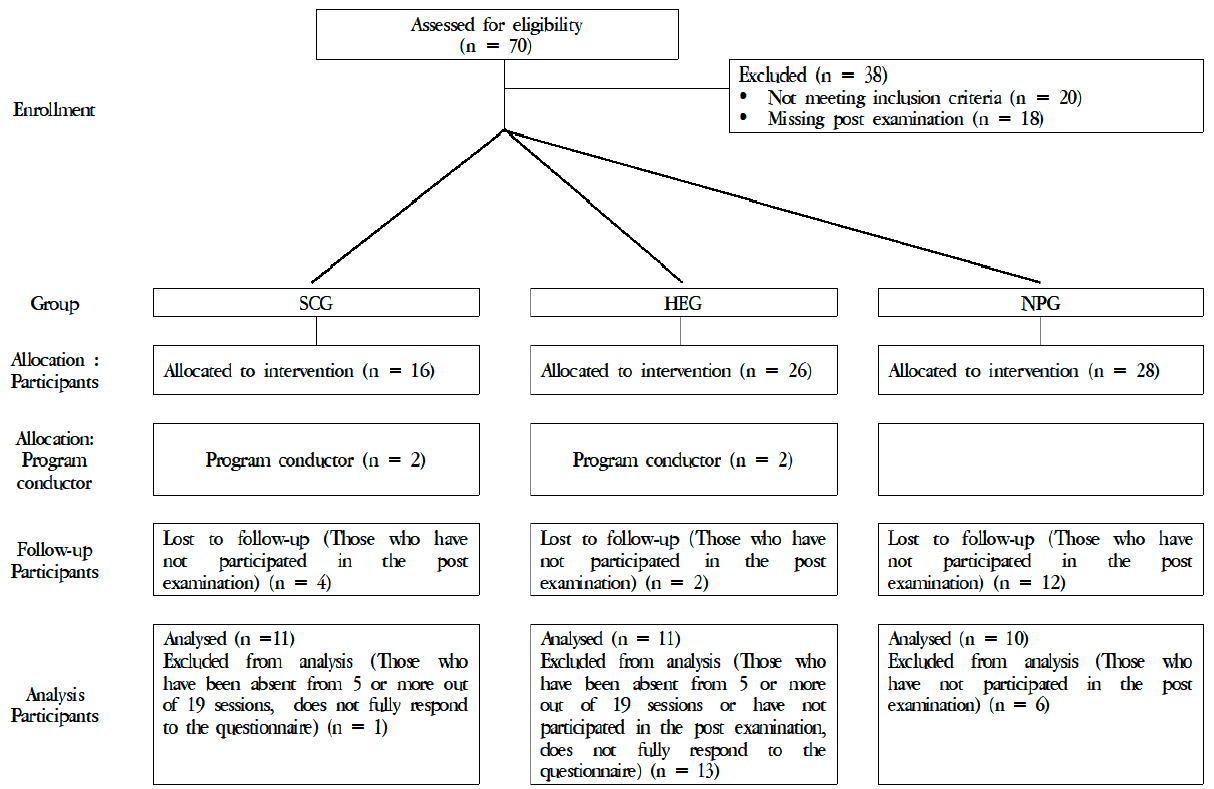
Figure 1. CONSORT (Consolidated Standards of Reporting Trials) flow diagram for individual controlled trials. The mean age (± standard deviation) of the participants was 60.7 ± 10.3 years (Table